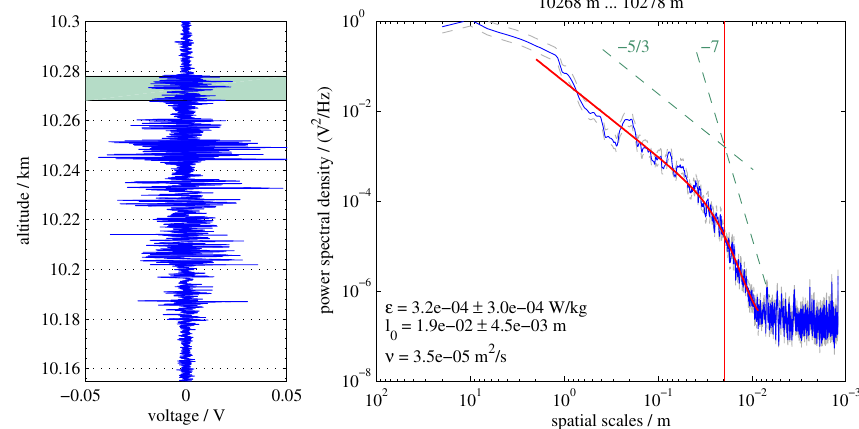
Figure 1. Example of raw data (left) and associated power spectrum (right) computed for the shaded area in the raw data plot. In the raw data, an amplitude of (cid:46) 1mV corresponds to instrumental noise. In the spectrum, the blue curve shows the measurement, the grey dashed lines the 95% confidence interval and the red curve the fit of the Heisenberg model to the measured spectrum; the red vertical line indicates the inner scale l 0 . The green dashed lines display slopes of − 5 / 3 and − 7. The errors given are fit errors.